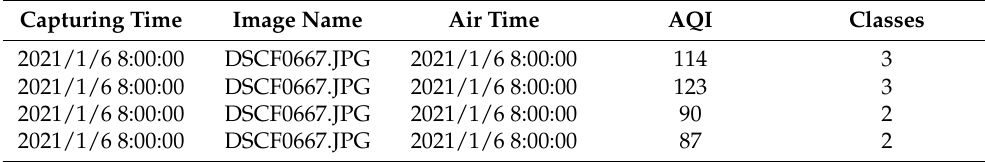
Figure 3. AQI data from the monitoring station for Karachi City. Table 2. Information about the dataset of samples. Table 2. Information about the dataset of samples.